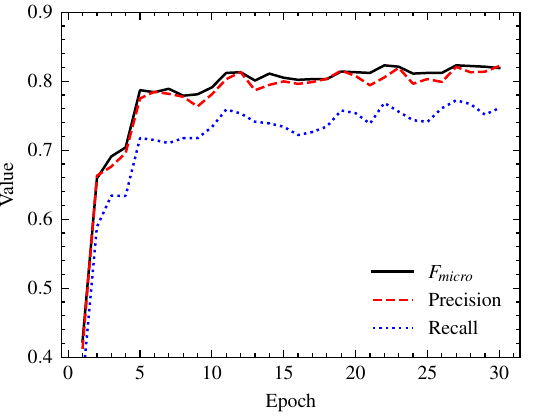
Figure 4. Precision, recall, and F micro value on entire test dataset in the training